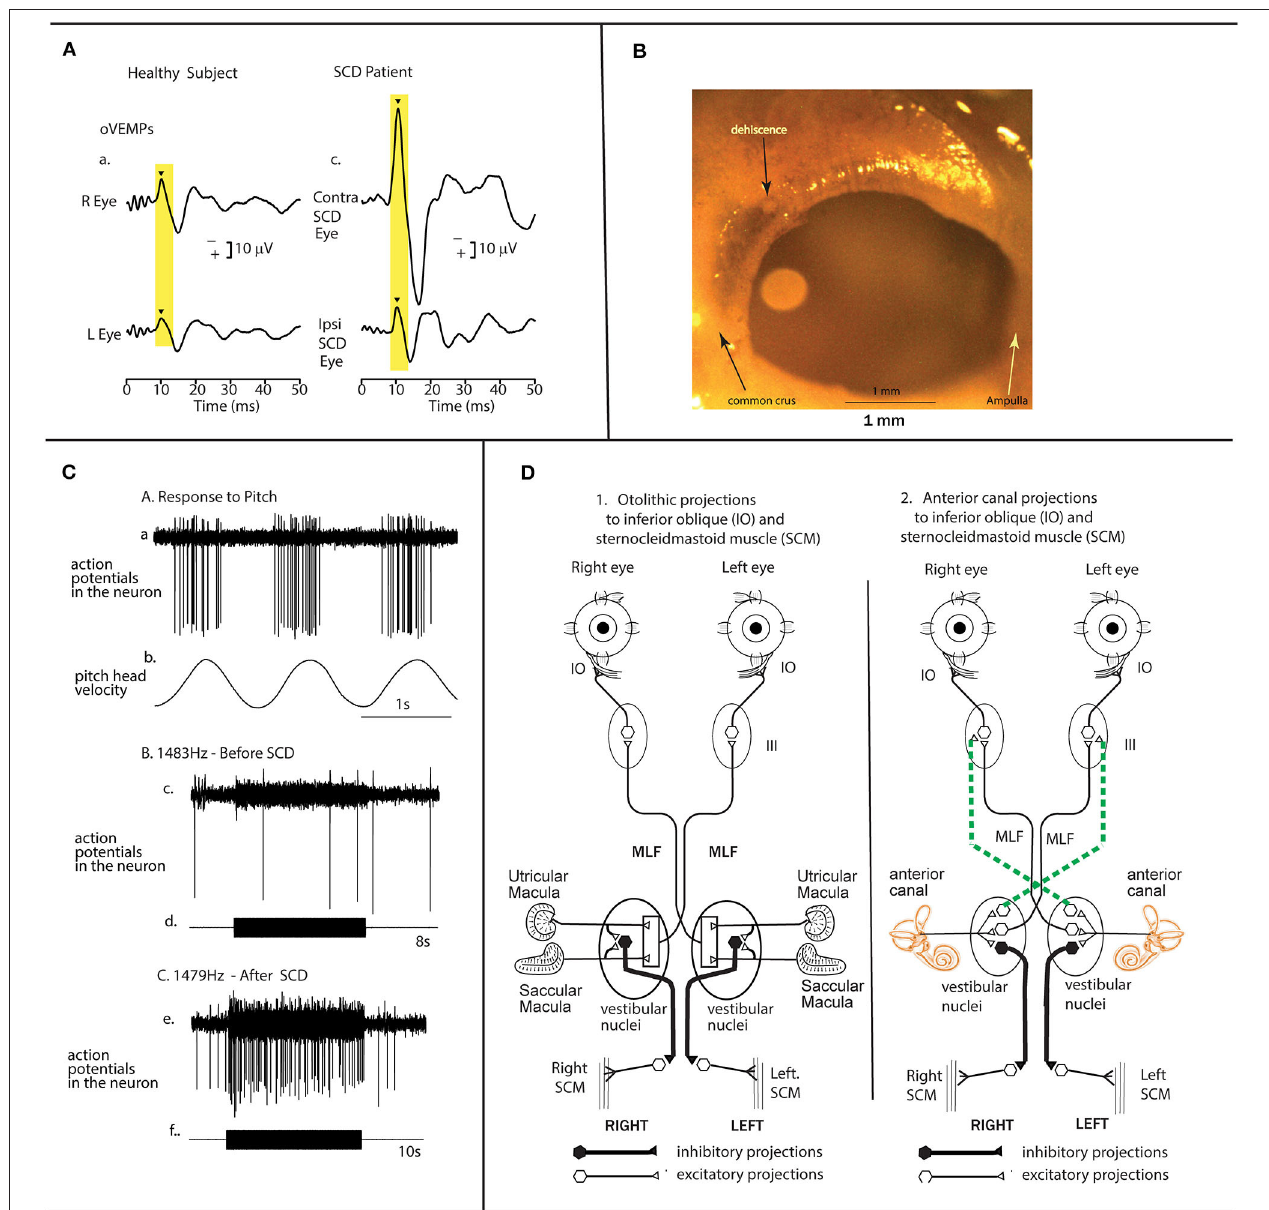
FIGURE 1 | The anatomical and physiological basis for enhanced oVEMP responses after a semicircular canal dehiscence. (A) Time series records of the oVEMP response of a patient with an SCD showing a greatly enhanced oVEMP n10 component beneath the eye contralateral to the SCD in response to 500Hz brief tone bursts. The typical oVEMP n10 response of a healthy subject to the same stimulus shows a much smaller n10 component [reproduced with permission from (4)]. (B) A view from a medial view point of the bony wall of the superior semicircular canal in a guinea pig showing the small (0.1mm diameter) dehiscence of the bony wall of the canal made during the experiment by shaving away the thin bone using a fine scalpel blade, while continuing to record from the same single neuron. In guinea pigs the canal is clearly visible after removal of the overlying cerebellum [reproduced with permission from (5)]. (C) After such an SCD, anterior canal neurons with irregular resting activity are activated and phase-lock to ACS and BCV at stimulus levels used for human clinical testing, whereas they do not respond to the same stimuli before SCD (6). In these experiments the same neuron was tested before and after the SCD. The response of one superior canal neuron to high-frequency air-conducted sound, before and after a small dehiscence in the bony wall of the superior canal. (a) The response of the neuron to pitch angular acceleration in the plane of the superior canal identifies the neuron as being a superior canal afferent. (b) Before SCD an 8s burst of 1,483Hz ACS has no effect on the neural response—there are very few action potentials during the tone burst. (c) After the SCD a 10s burst of an air-conducted sound of 1,479Hz causes strong activation of this same neuron. Reproduced with the permission of John Wiley and Sons Inc., from (3). (D) The projections of otolithic (D1) and canal (D2) neurons to IO and SCM [redrawn from (7)]. These are schematic diagrams of a view of the brainstem to show the otolithic projections to IO and SCM on the left (1) and the superior canal projections to IO and SCM on the right (2). These projections were derived from experiments using electrical stimulation to identify the projections. Stimulation in animals with intact labyrinths causes the otolithic neural connections shown in 1 to be activated, so ACS and BCV generate the oVEMP and cVEMP responses without any input from semicircular canal neurons, since canal afferents are not activated by ACS and BCV at frequencies above 200Hz (8). However, after an SCD,